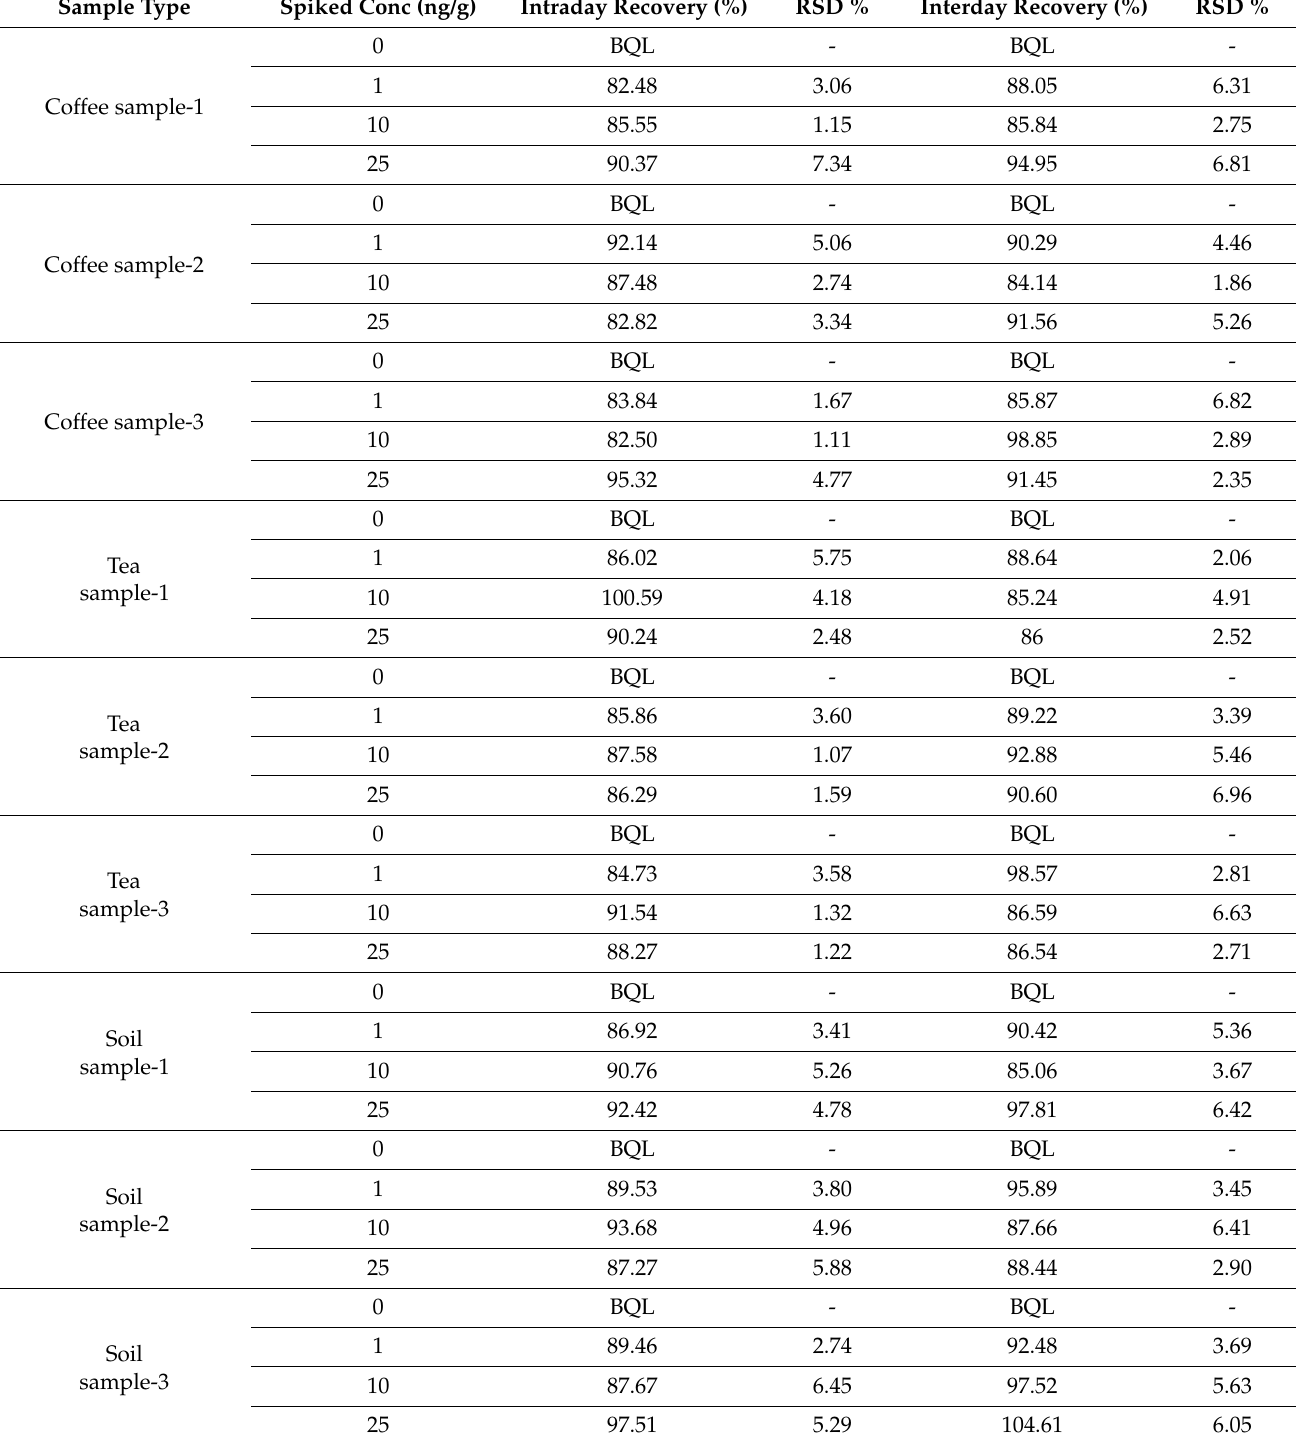
Table 1. Real sample analysis (coffee, tea, and soil) by the proposed method (n =